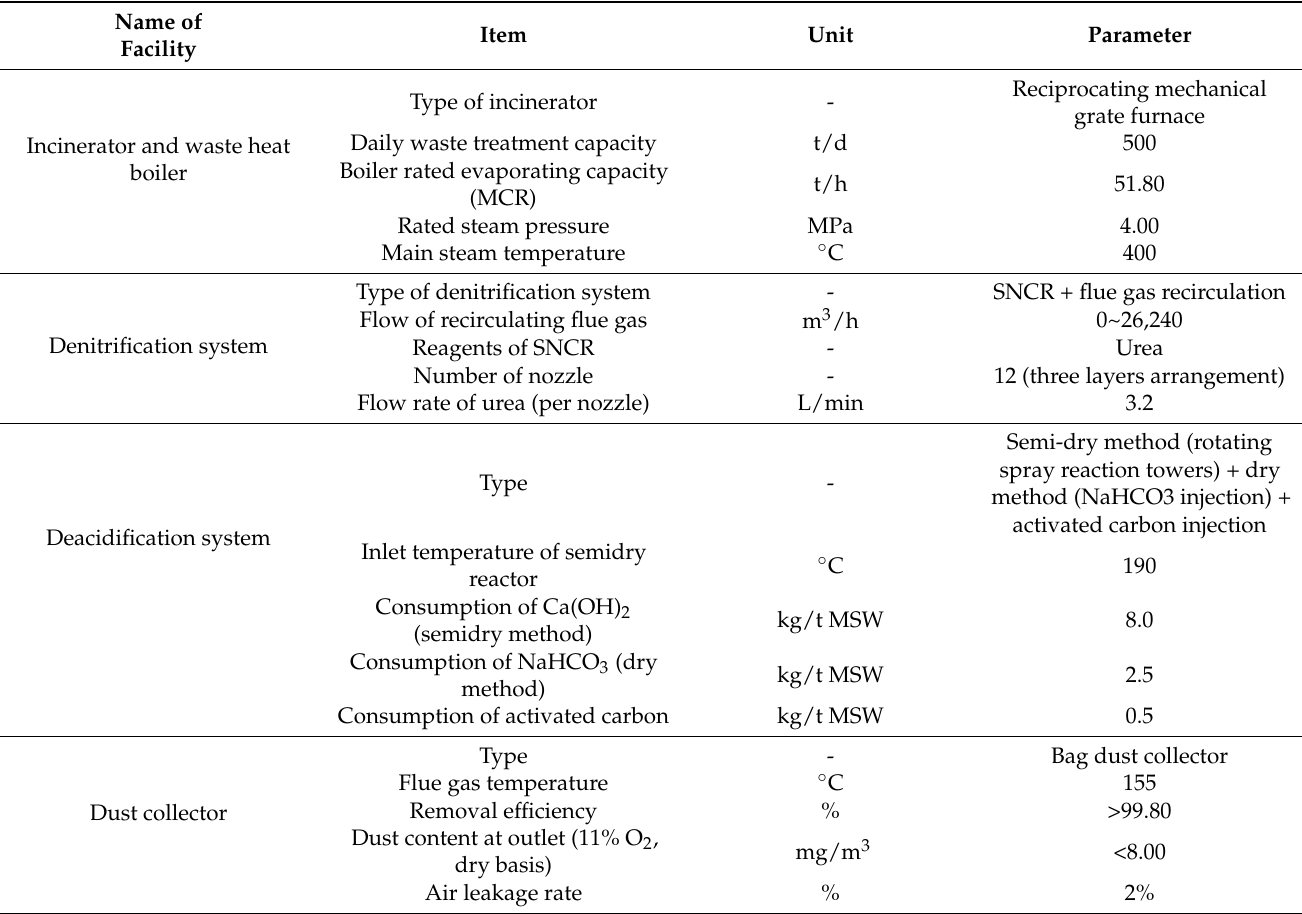
Table 2. Specifications of the main equipment and environmental